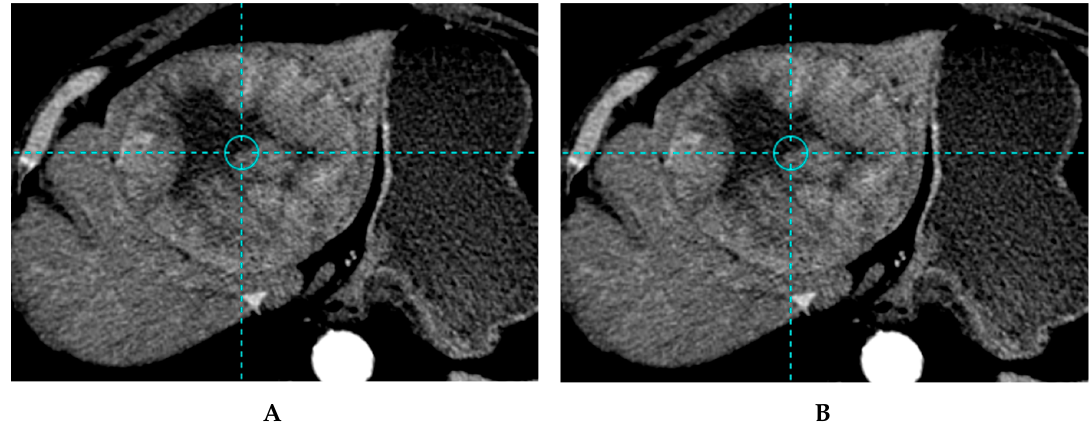
Figure 2. Example of a patient treated with the standard dosimetry approach, with a lesion under-treated (tumor dose below the 205 Gy threshold) ( A ) Baseline CT image of bilobar HCC with a 10.7 cm lesion of the left lobe and a 5.2 cm lesion of segment V in a 70-year-old patient with good performance status (ECOG 0) and liver functions (Child Pugh A5). The patients received a treatment of the left lobe with 1.93 GBq of 90 Y glass microspheres using the standard dosimetry approach delivering 140 Gy to the large lesion and 117 to the left lobe. On the CT image, 3 months after SIRT, stable disease was observed ( B ). Overall survival of this patient was 8.7 months.